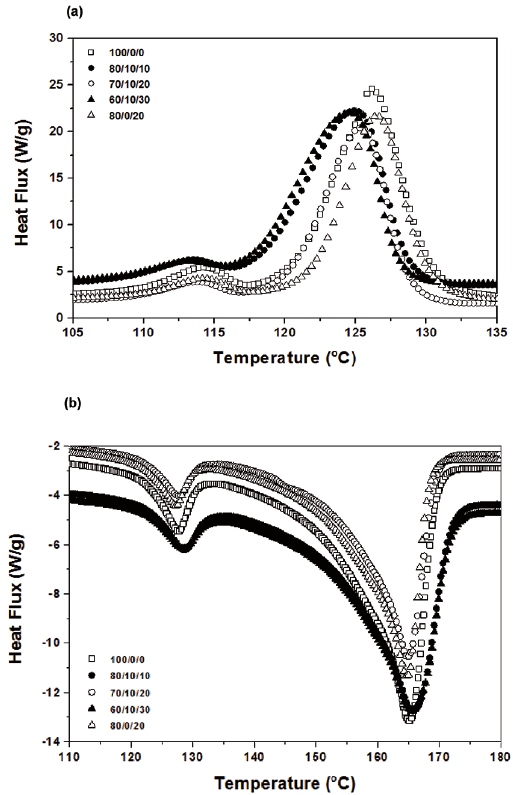
Figure 4: (a) DSC cooling curves and (b) 2nd heating curves.